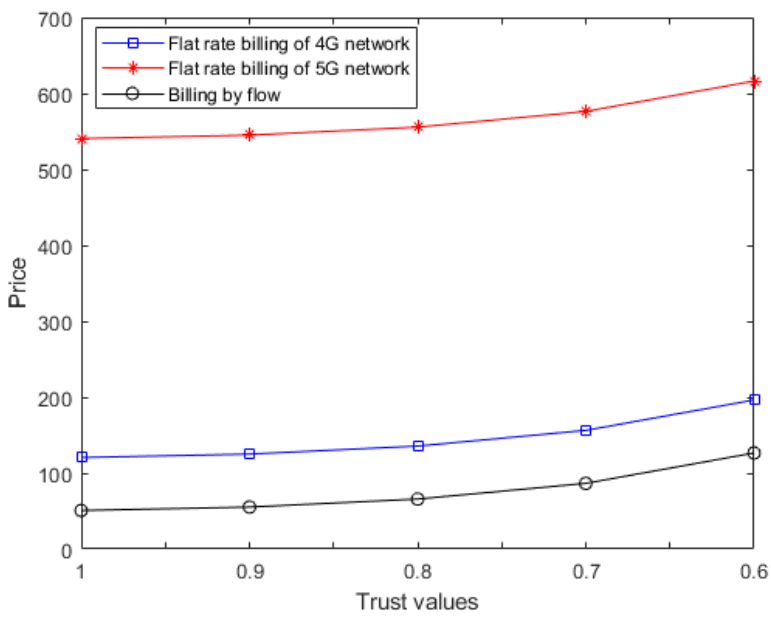
Figure 7. Service price based on different trust